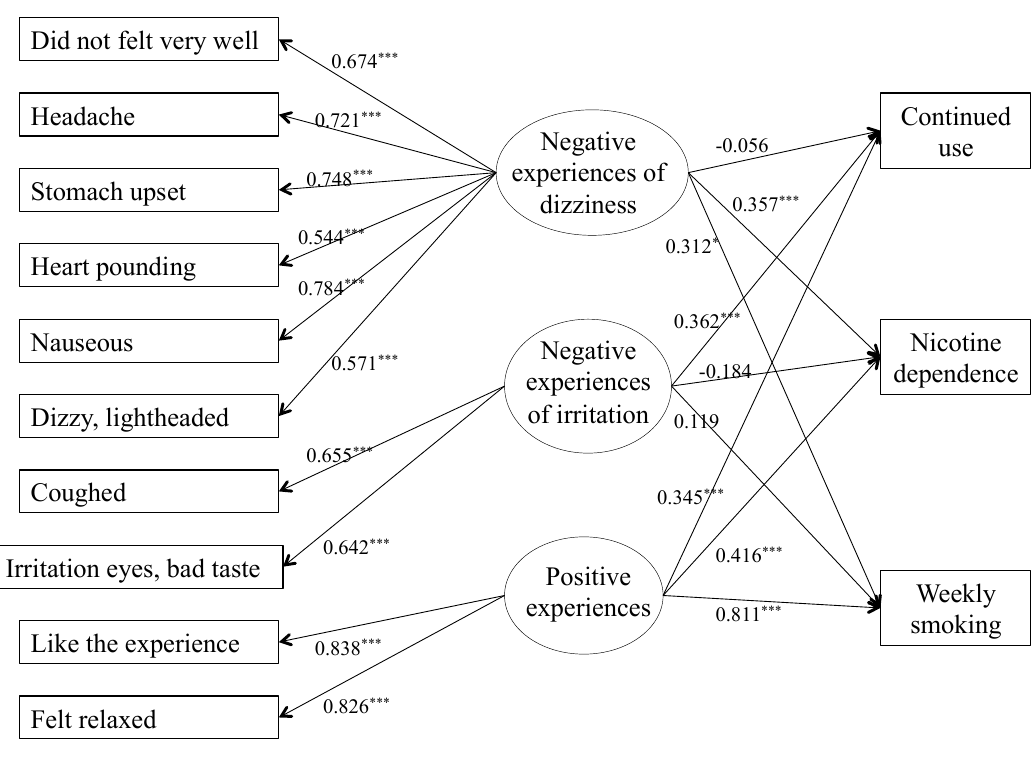
Figure 3. SEM for three-factor